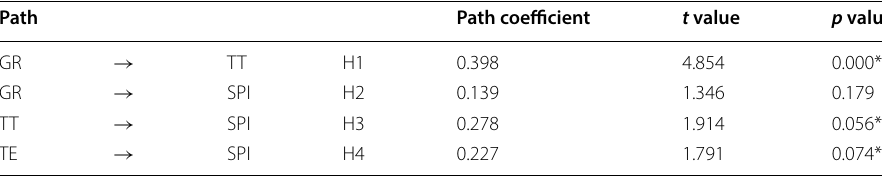
Table 8 Path coefficient test. Source: Author data, Smart PLS